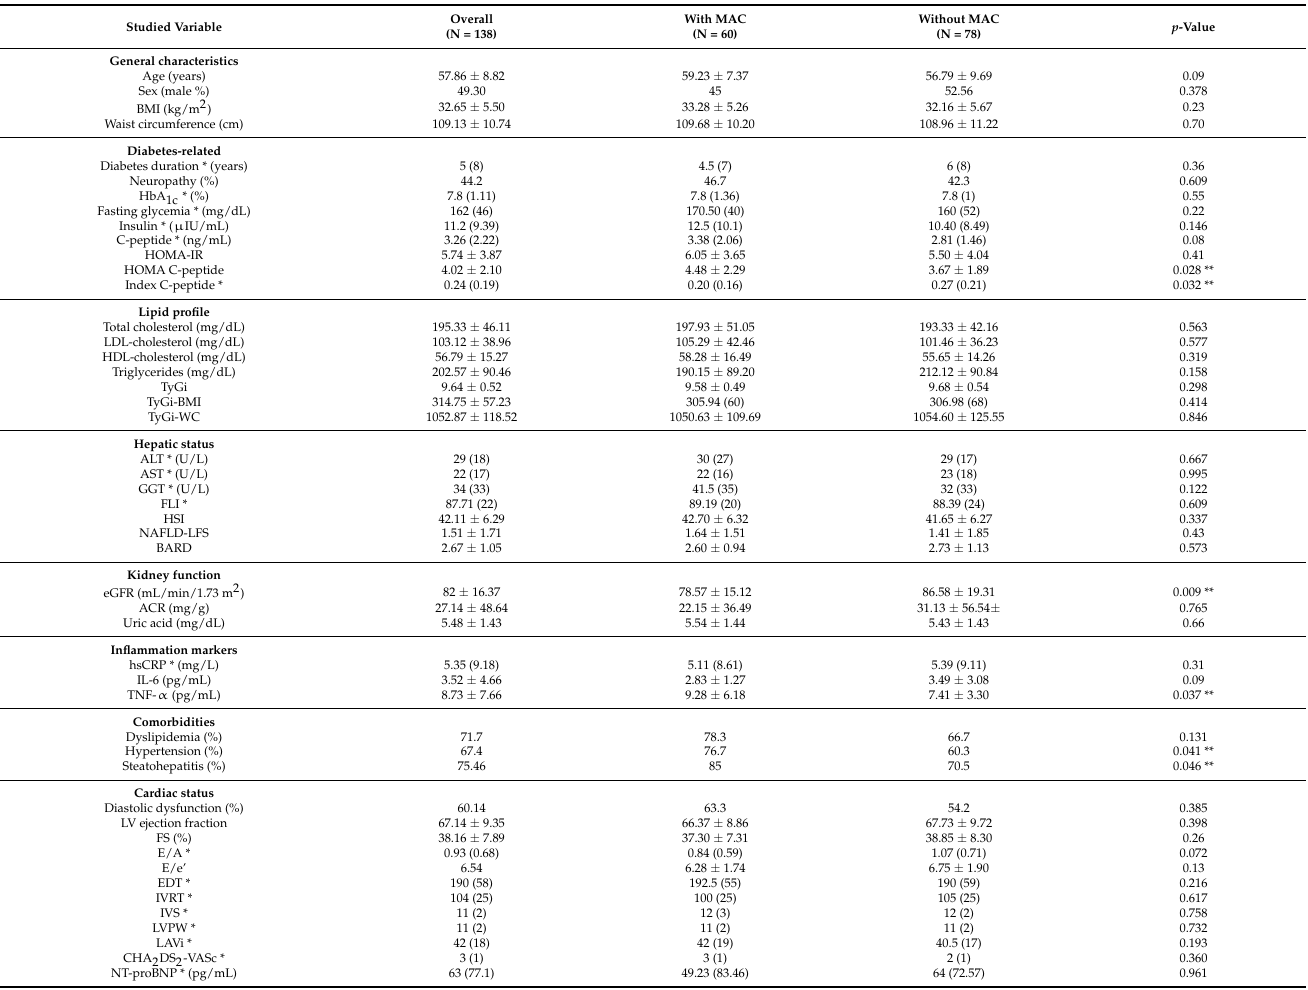
Table 1. Patient characteristics overall as well as by MAC